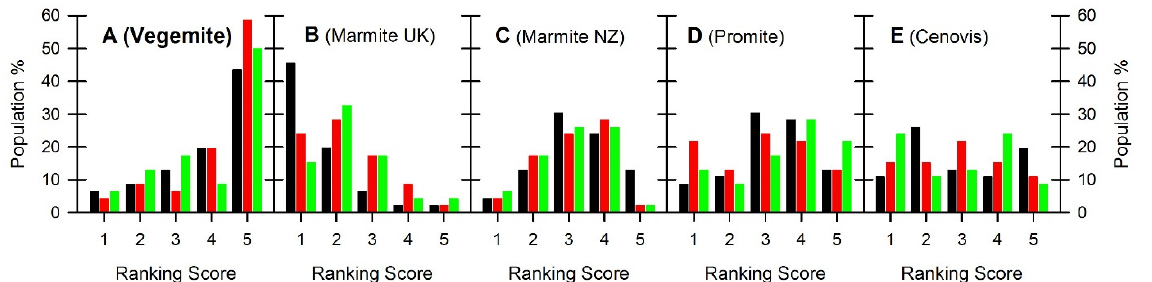
Figure 2. Ranking of yeast spreads in impromptu sensory sessions in Australia ( n = 92). ( A ) ranking received by Vegemite (in bold); ( B ) rankings received by the UK Marmite; ( C ) rankings received by the New Zealand Marmite; ( D ) ranking received by Promite; and ( E ) rankings received by Cenovis. Rankings ranged from 1 to 5 as from low to high. Black bars represent the sensory perception based on sight only. Red bars represent the sensory perception based on smell only. Green bars represent the sensory perception based on taste only. Friedman ranking tests for all three attributes returned p < 0.01.